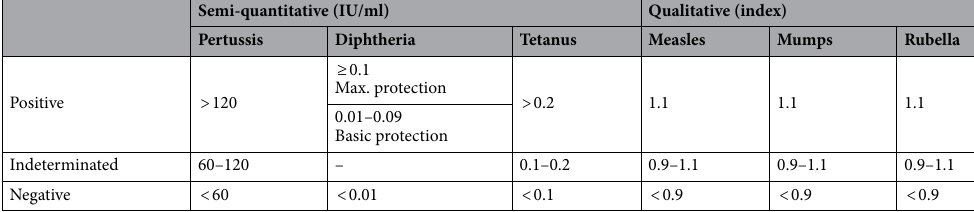
Table 1. VirClia-IgG (VIRCELL) cut-off values for plasma/serum. IU International units, ml Millilitre, Max. protec. Maximum. Data according to technical files provided by